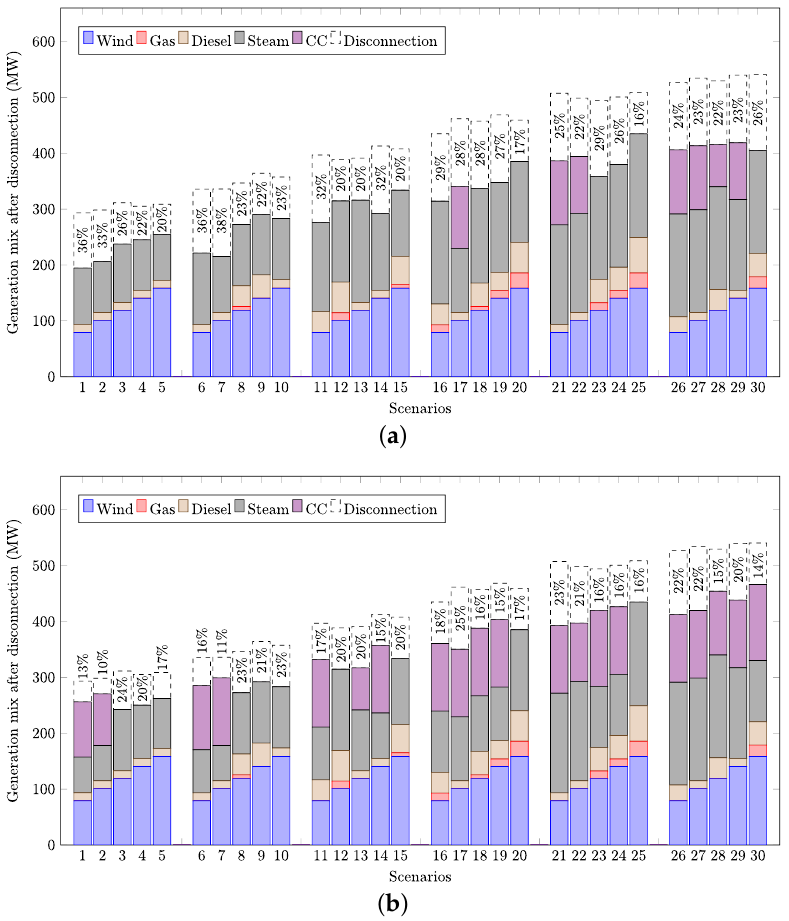
Figure 8. Generation mix after disconnection ( a ) Largest power plant disconnection. ( b ) Second largest power plant